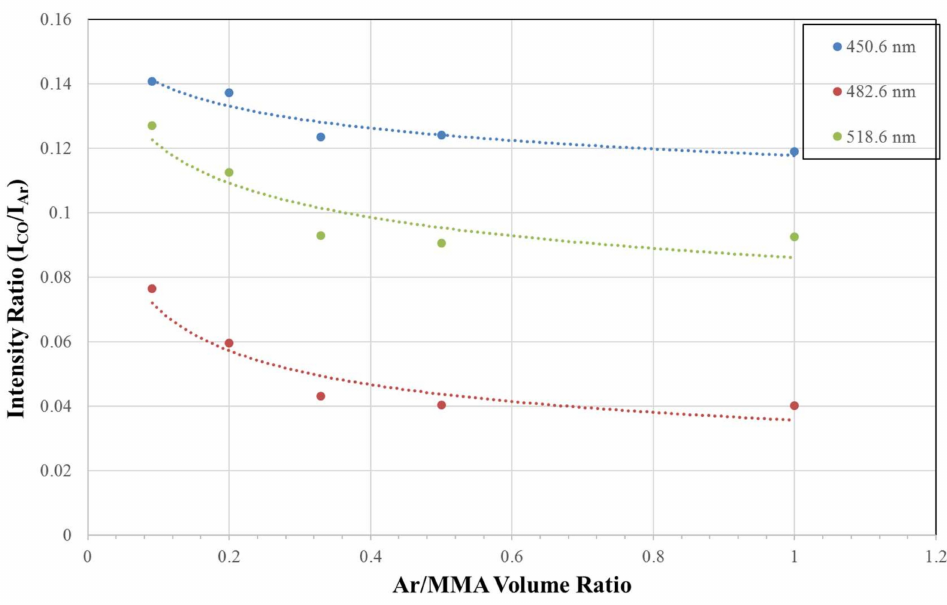
Figure 6. OES intensity ratio of Ar peak to CO peaks vs. Ar/MMA volume